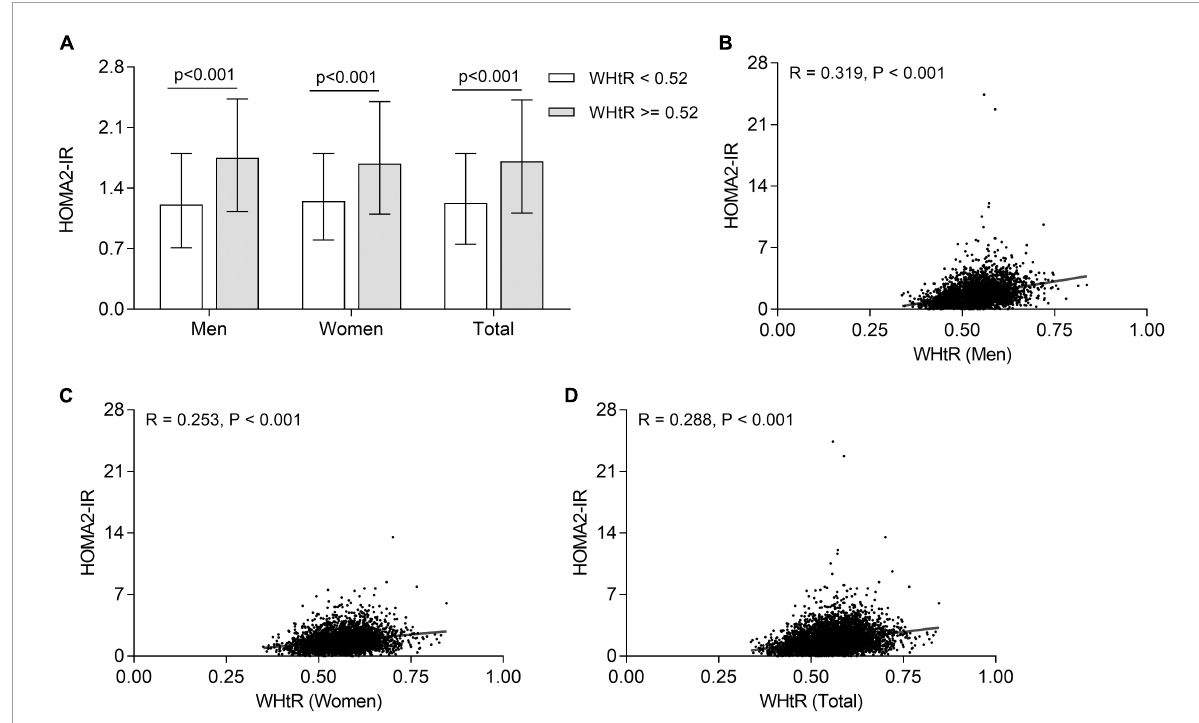
FIGURE4 Association of WHtR with insulin resistance in T2DM patients. (A) Comparison of HOMA2-IR stratified by sex between the subjects with WHtR < 0.52 and ≥ 0.52 after adjustment for age and DD. (B) Correlation of WHtR with HOMA2-IR in men T2DM patients. (C) Correlation of WHtR with HOMA2-IR in women T2DM patients. (D) Correlation of WHtR with HOMA2-IR in all T2DM